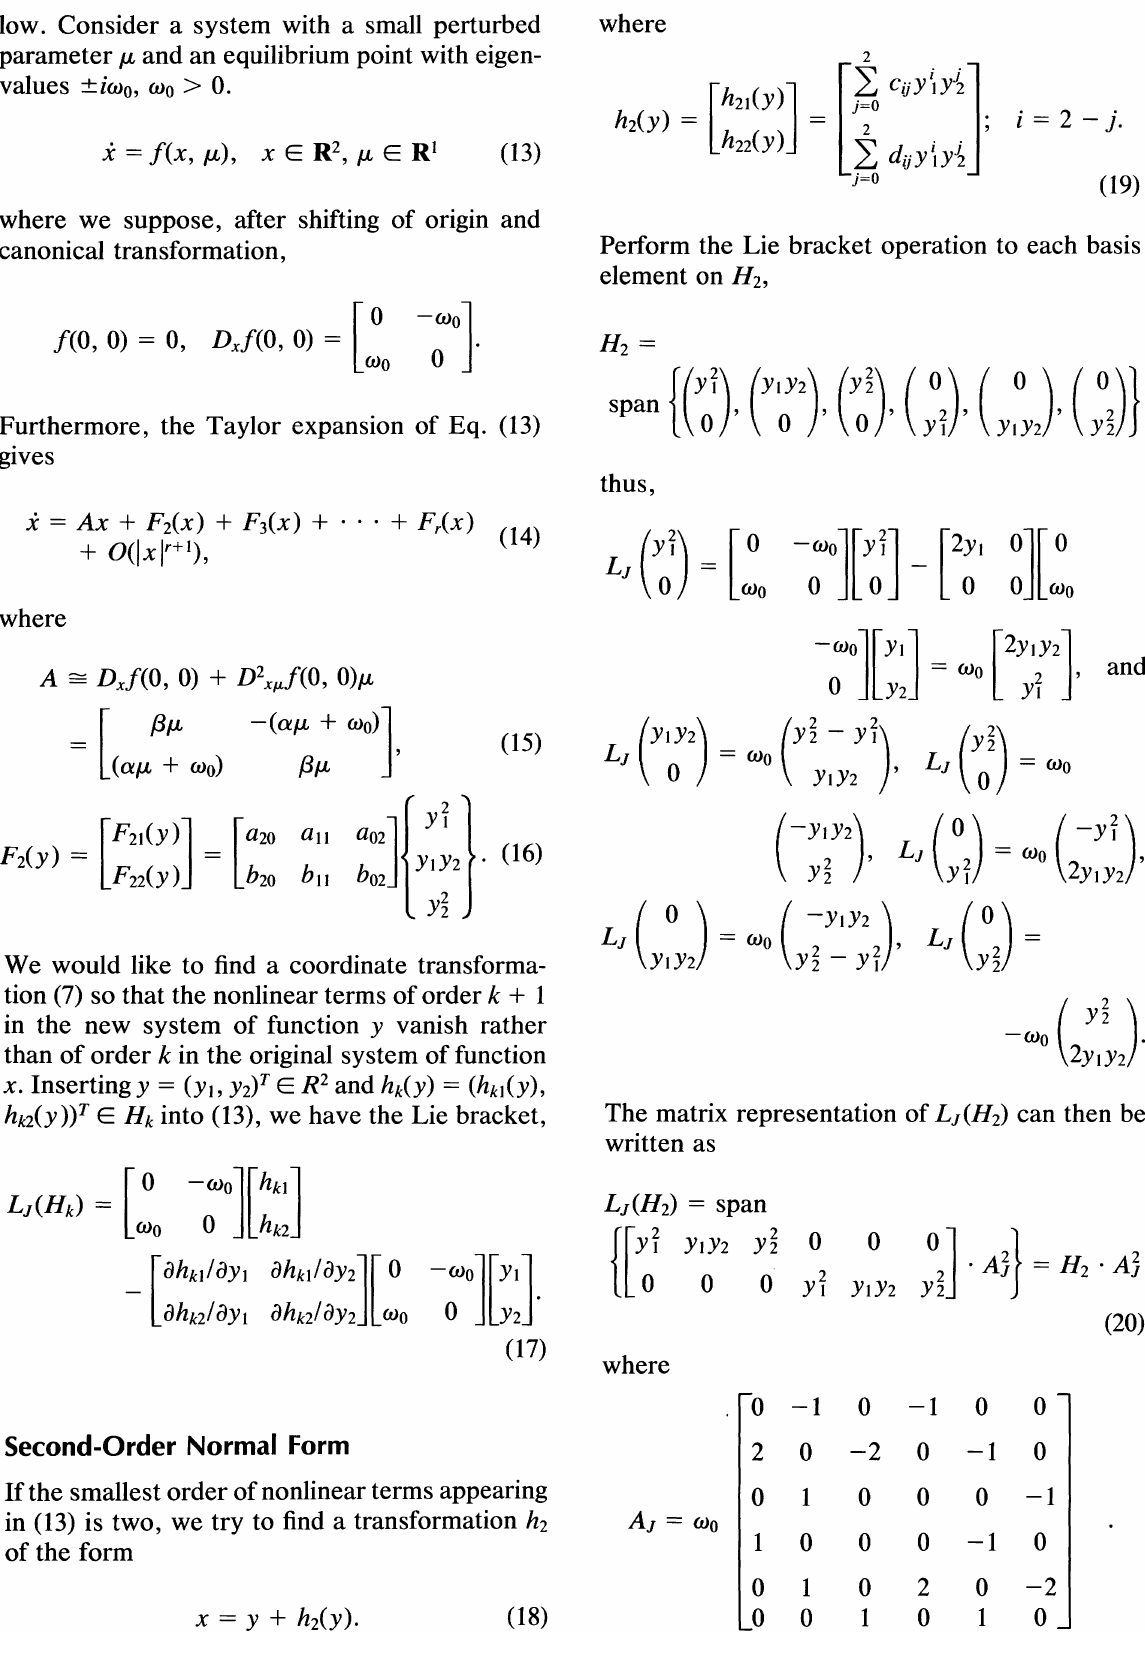
Algorithm for Higher Order Hopf Normal